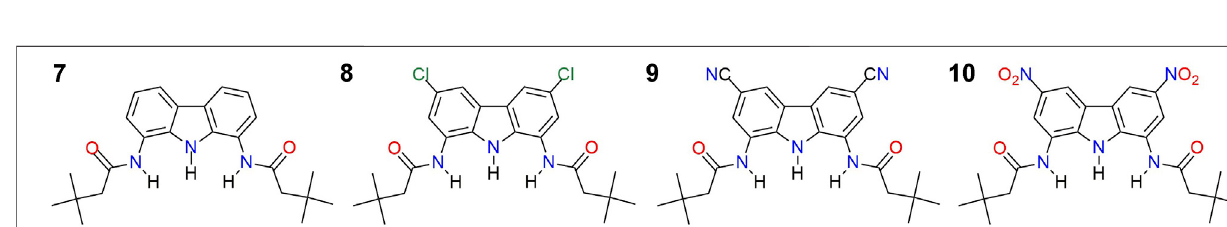
FIGURE 2 | Diamidocarbazole transporters 7 – 10 investigated in the present